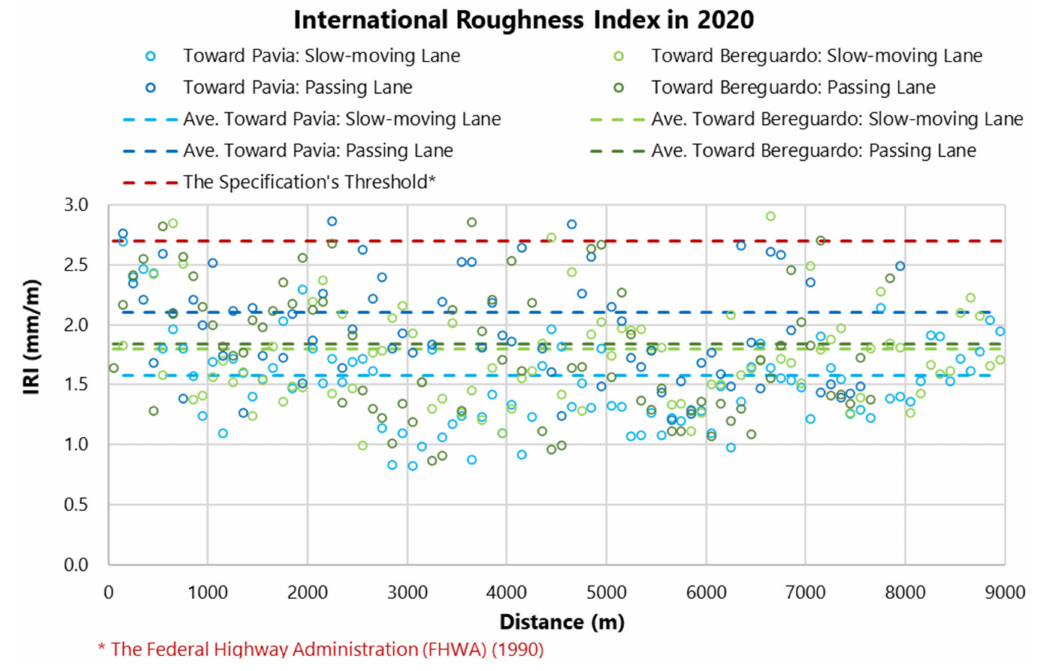
Figure 11. The International Roughness Index (IRI) after 5 years of pavement